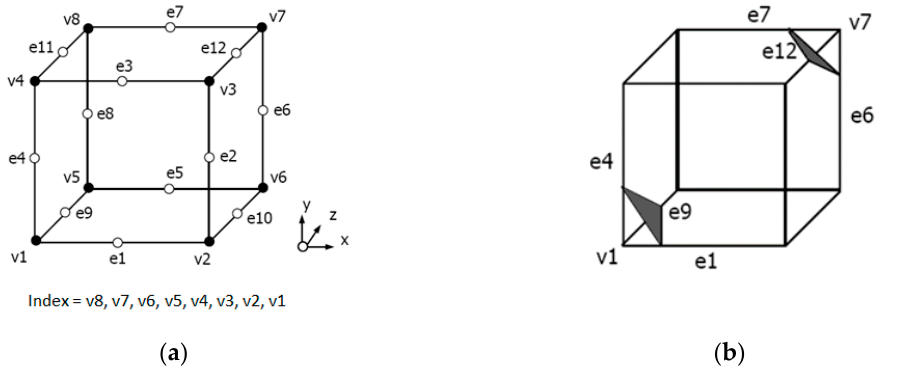
Figure 5. ( a ) The configuration of index; ( b ) The example of index contains value “01000001” and the triangular cross-section according to index value.